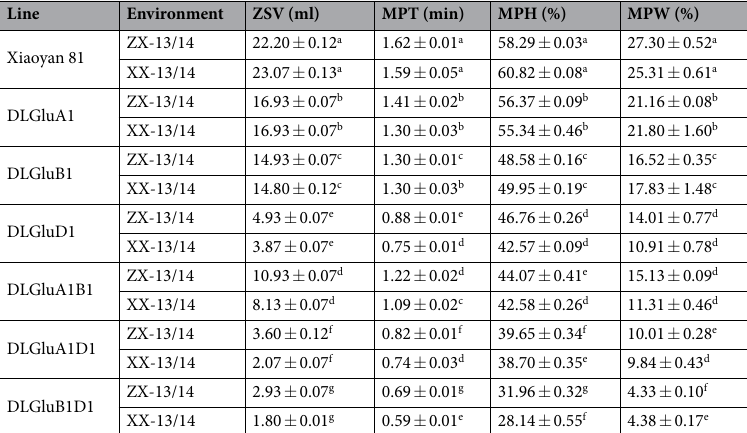
Table 1. Comparison of ZSV and three Mixograph parameters among Xiaoyan 81 and six deletion lines grown in 2013/2014 a . a Each value is the mean ± SE of three independent tests. Different letters after the means indicate statistically significant difference ( P < 0.05). MPH, midline peak height; MPT, midline peak time; MPW midline peak width; XX, Xinxiang; ZSV, Zeleny sedimentation volume; ZX,